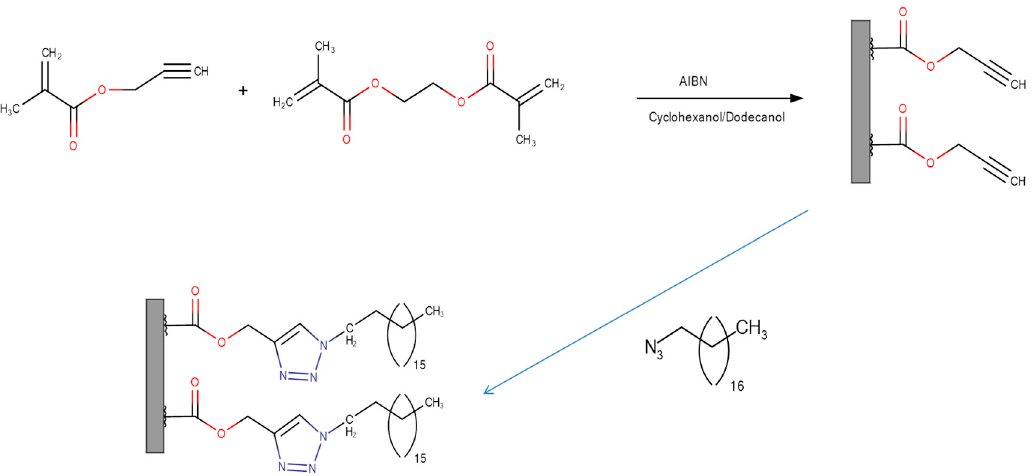
Figure 7. Formation of methacrylate monolith with alkyne functional group, and reaction scheme of the CuAAC reaction for the modification of polymer surface with C 8 and C 18 ligands. Redrawn from [111].